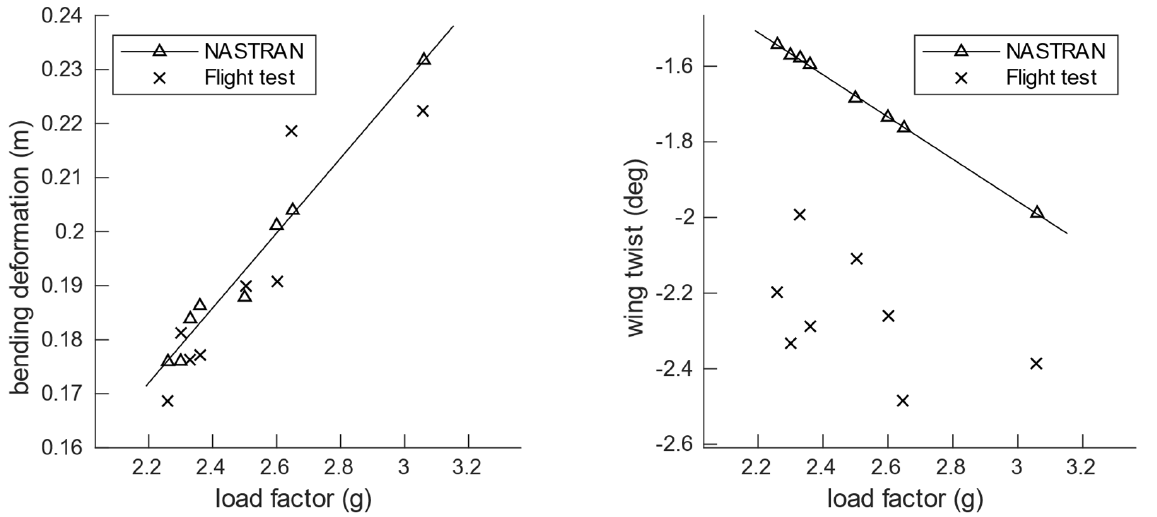
Figure 17. Bending and twist deformation (near wing tip—at spanwise location 2.95 m) at different flight test manoeuvres for the reference wing.